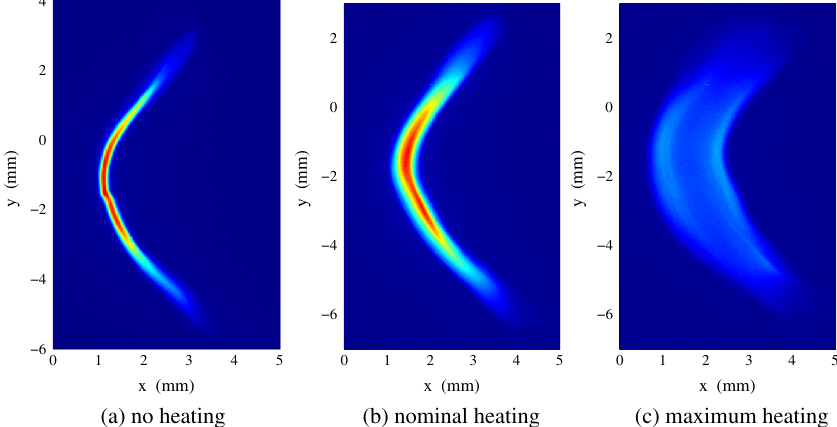
FIG. 5. (Color) Measured longitudinal phase space on ‘‘YAGS2’’ screen at 135 MeV with (a) laser heater off, (b) IR-laser energy at 10 (cid:1) J , and (c) at 220 (cid:1) J ¼ 150 (cid:1) m is the rms electron transverse size, and (cid:6) x ¼ 210 (cid:1) m is the rms laser spot size in the undulator. (cid:6) r The peak laser power is estimated based on the measured laser energy and the measured FWHM pulse length as